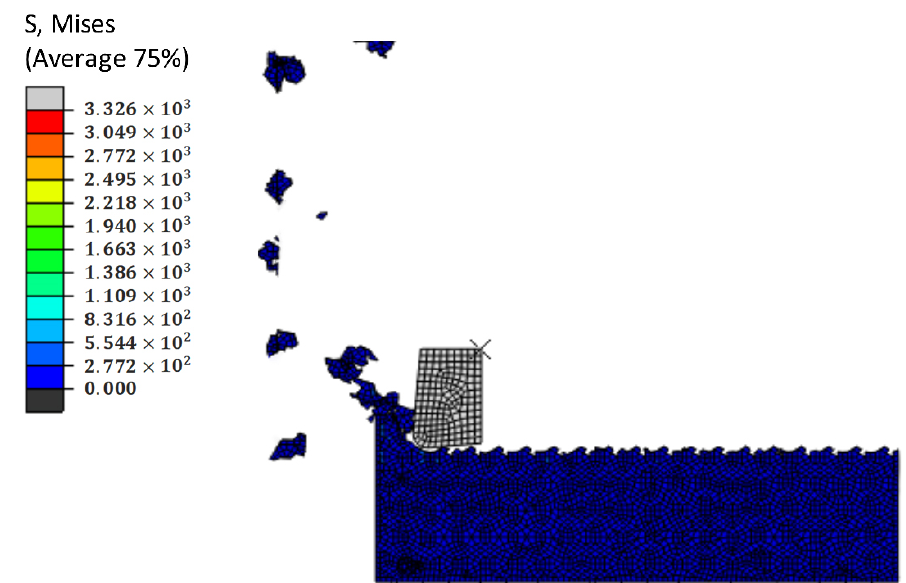
Figure 18. Surface topography under optimal cutting parameters.